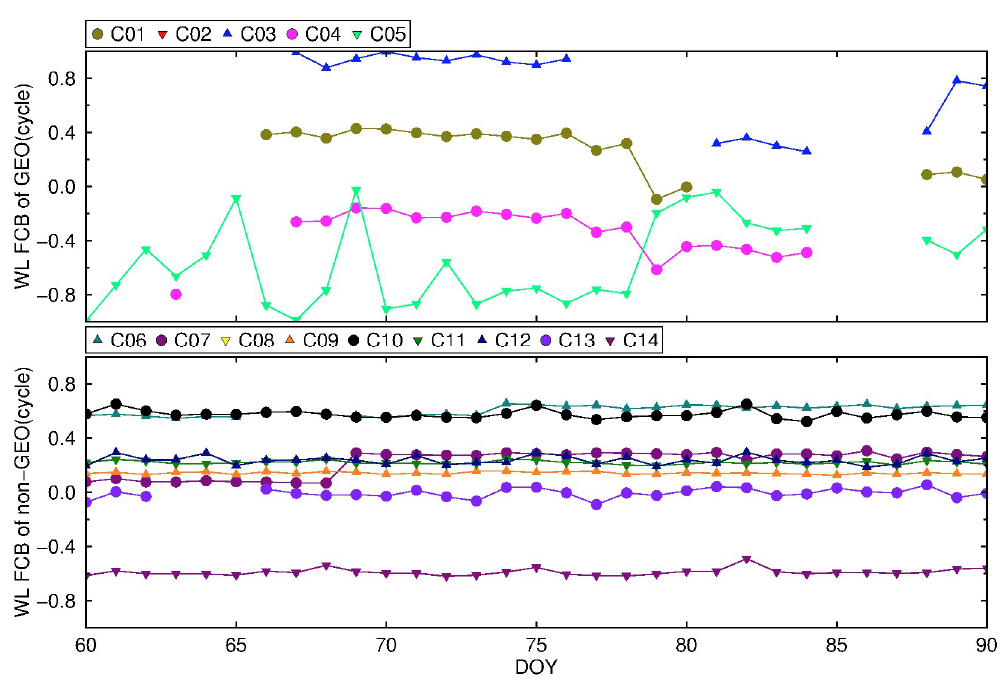
Figure 10. The variation of BDS WL FCB by the new strategy from DOY 061 to 090, 2018.